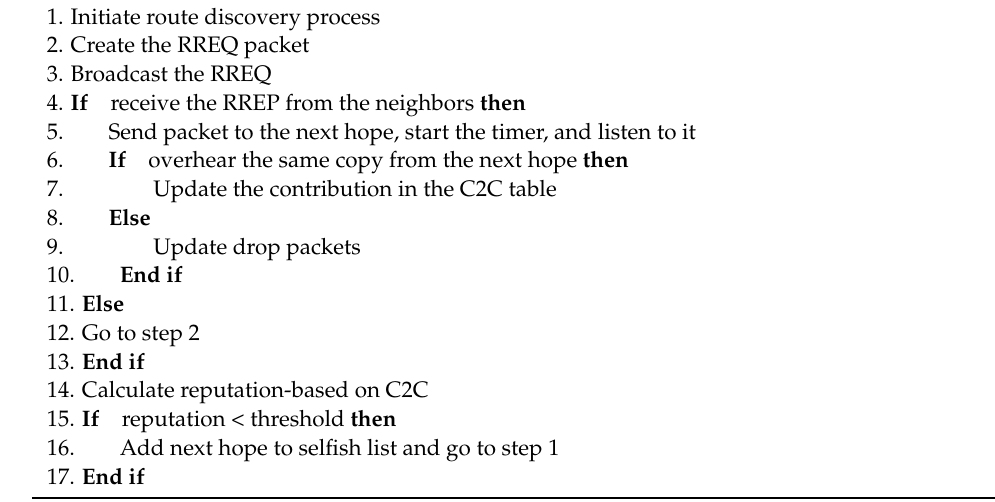
Algorithm 1. Reputation calculation for intermediate node ( F ) by source node ( S )